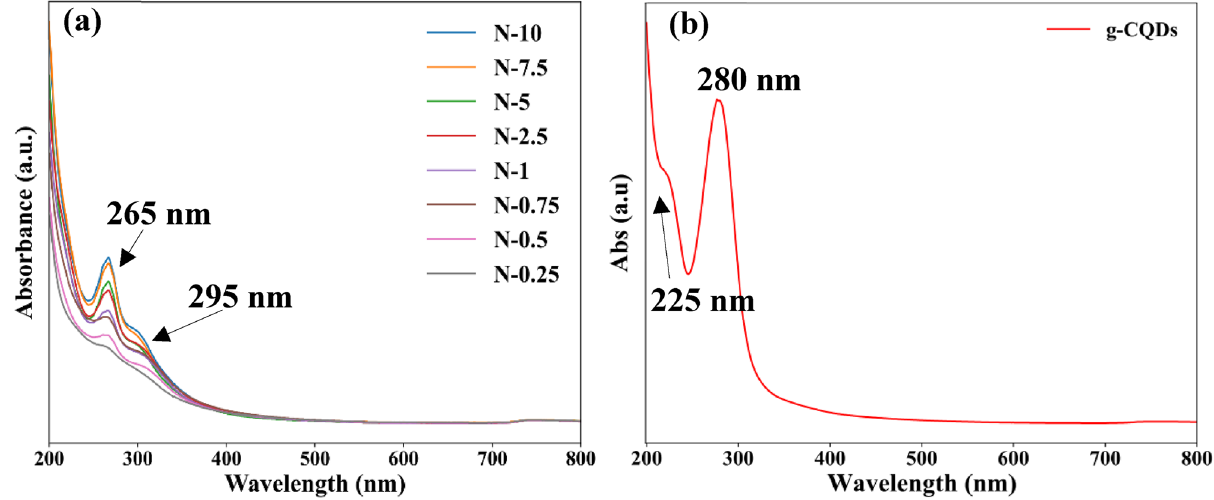
Figure 4. ( a ) UV–Vis absorption spectra of ( a ) N-CQDs and ( b ) g-CQDs without nitrogen doping. The presence of C–N/C=N bonds is observed at 295